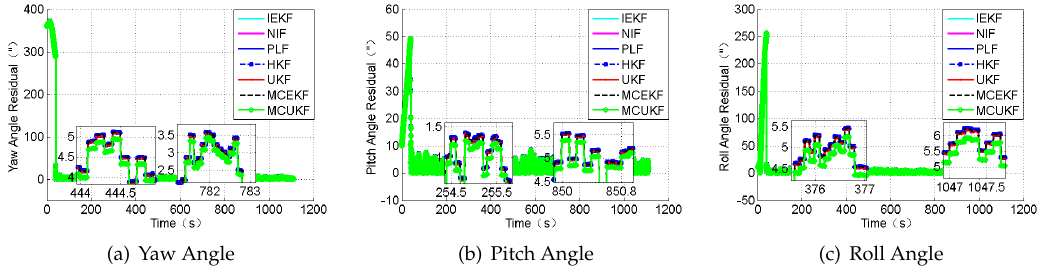
Figure 13. The attitude angle residual under the condition of the Gaussian mixture noises.